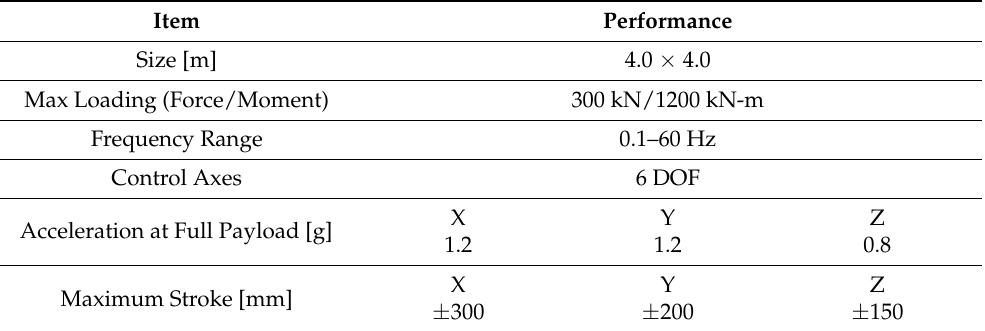
Table 5. Performance and specification of 3D shaking table.